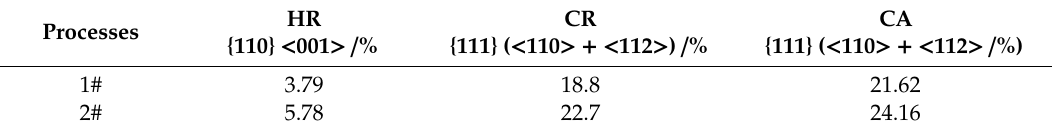
Table 3. The statistics of favorable texture content in each rolling process.